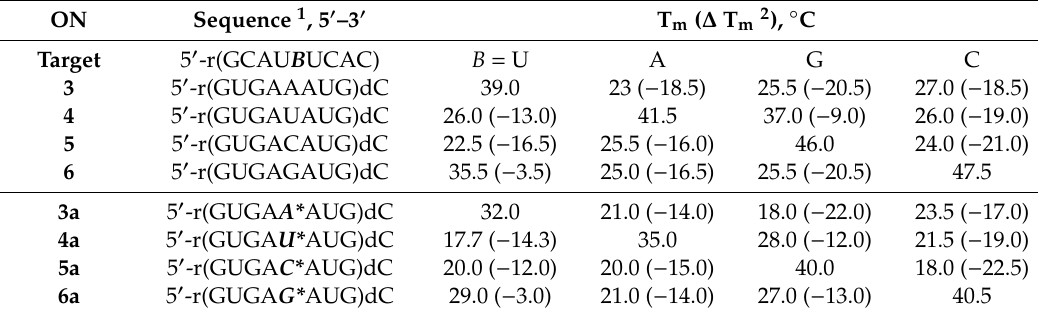
Table 2. Thermal denaturation temperatures (T m values) of duplexes between 3 – 6 and 3a – 6a and complementary or centrally mismatched RNA targets.